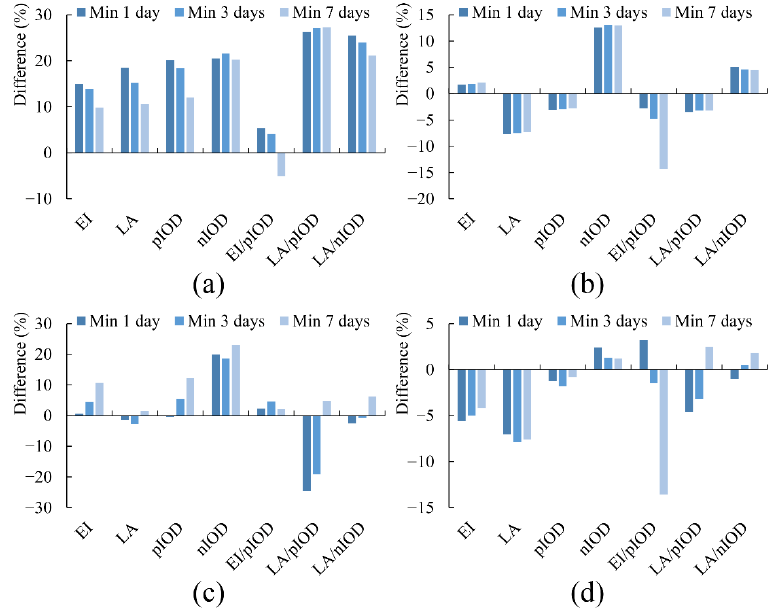
Figure 11. The difference in 1-day/3-day/7-day minimum streamflow in decaying years in develop- ing years at ( a ) Zhimenda, ( b ) Shigu, ( c ) Tongzilin, and ( d ) Xiangjiaba.